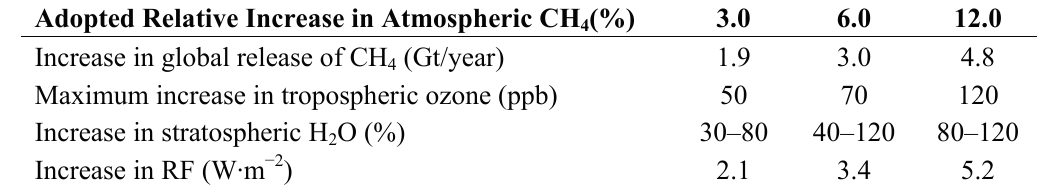
Table 2. Modeled increase in the global release of CH and stratospheric increase of water vapor, and the total radiative forcing for the selected atmospheric methane enhancements. Calculations are done with the Oslo chemistry transport model (Oslo